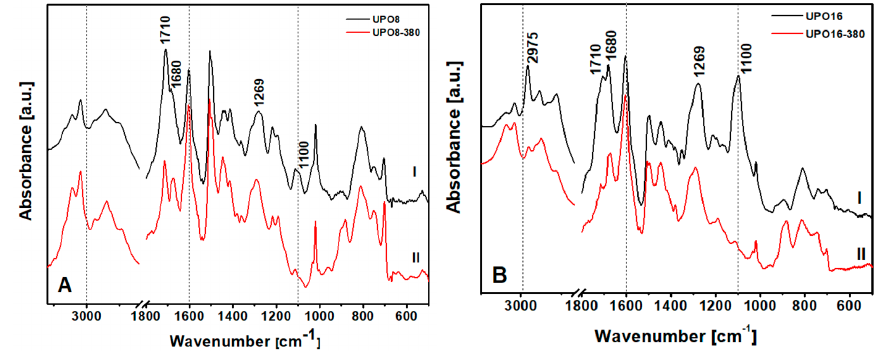
Figure 4. FTIR spectra in the region 3100–600 cm − 1 of ( A ) UPO8 and ( B ) UPO16—samples before (I) and after (II) the thermal treatment at 380 ◦